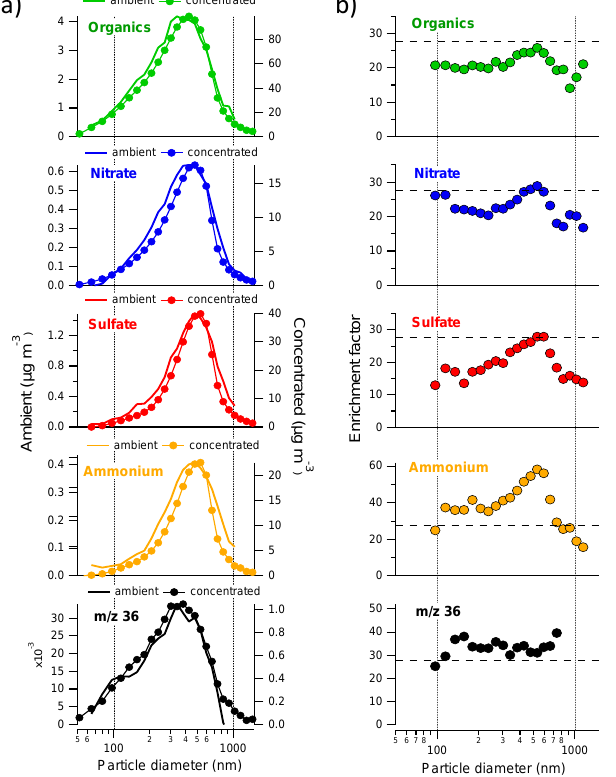
Fig. 7. Figure 7. Average mass–size distributions for organics, nitrate, sul- fate, ammonium and m/z 36 (surrogate for r-BC) for ambient and concentrated aerosol (a) and the corresponding EFs (b) . m/z 36 was measured only with the laser on. Clear outliers were excluded from (b) and ammonium and m/z 36 were smoothed by 1 point due to low a signal-to-noise ratio for ambient size distributions. Dashed lines in (b) represent the average EF for the SP-AMS (26.7).